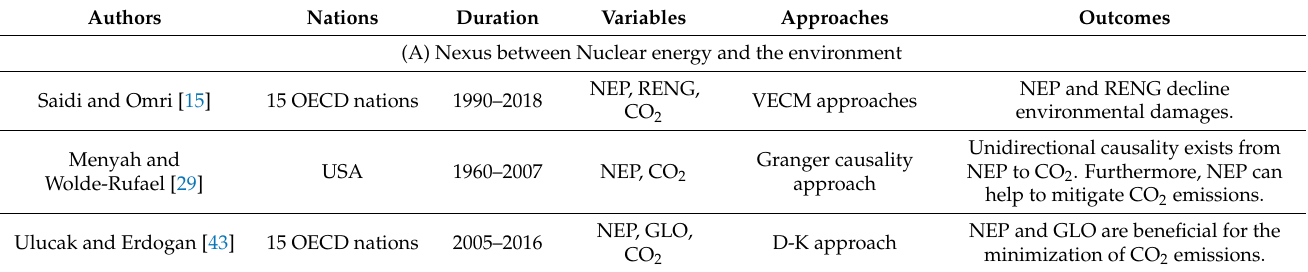
Table 1. Summary of the existing published literature between NEP